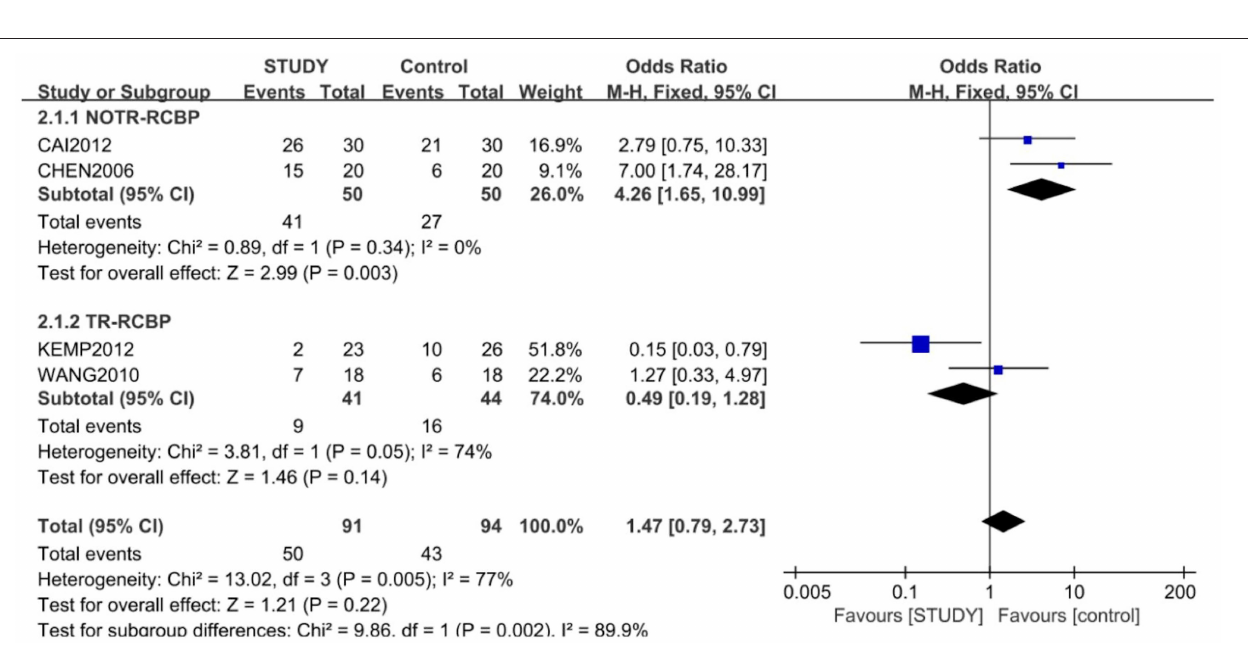
FIGURE 4 | Comparison of remission rate between the study and control groups. Three of the 5 studies, with 145 subjects, were included for the meta-analysis of remission rate, which was 47.9% in the study group and 45.9% in the control group. The random-effects model was used for this analysis ( X 2 = 4.42, df = 2, P > 0.05, I2 = 55%). No difference in remission rate was found between the two groups (OR = 1.05; 95% CI: 0.49 ∼ 2.25; Z = 0.13, P > 0.05).